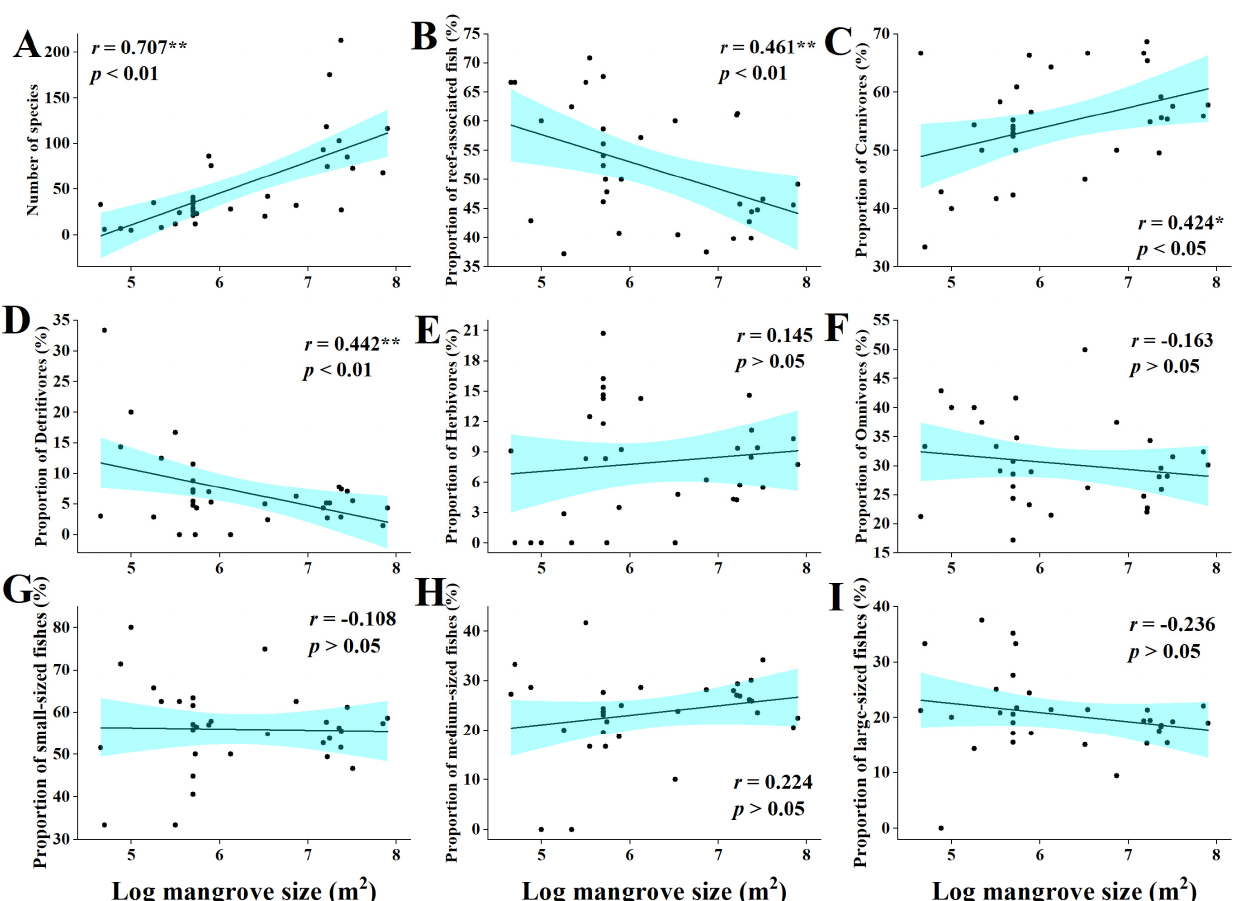
Figure 6. Relationship between mangrove size and characteristics of fish communities. ( A ) The relationship between number of fish species and the mangrove size. ( B ) The relationship between reef-associated fish and the mangrove size. ( C ) The relationship between carnivores and the mangrove size. ( D ) The relationship between detritivores and the mangrove size. ( E ) The relationship between herbivores and the mangrove size. (F) The relationship between omnivores and the mangrove size. ( G ) The relationship between small-sized fishes and the mangrove size. ( H ) The relationship between medium-sized fishes and the mangrove size. (I) The relationship between large-sized fishes and the mangrove size. (**: Extremely Significant, p < 0.01. *: Significant, p < 0.05).